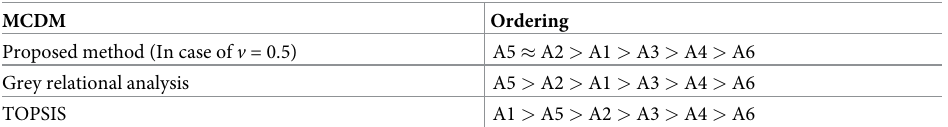
Table 15. Comparison with other